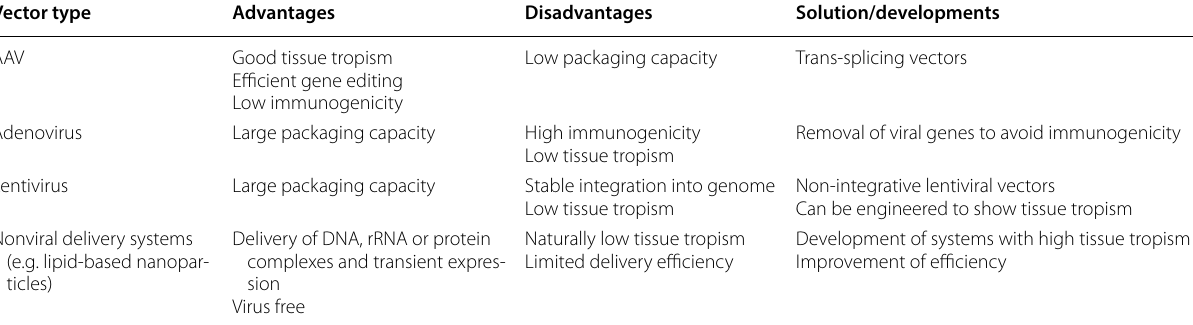
Table 3 Comparison of gene editing delivery systems Vector